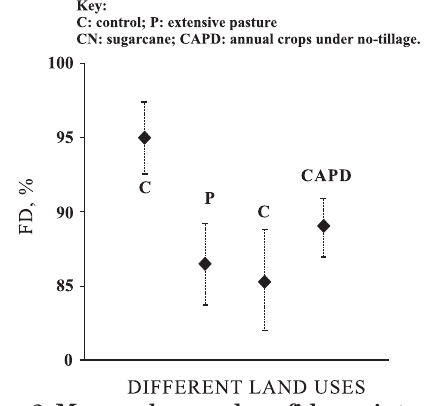
Figure 2. Mean values and confidence interval (95 %) for soil flocculation degree (FD), calculated for the 0–20 cm soil layer in areas of different land uses.